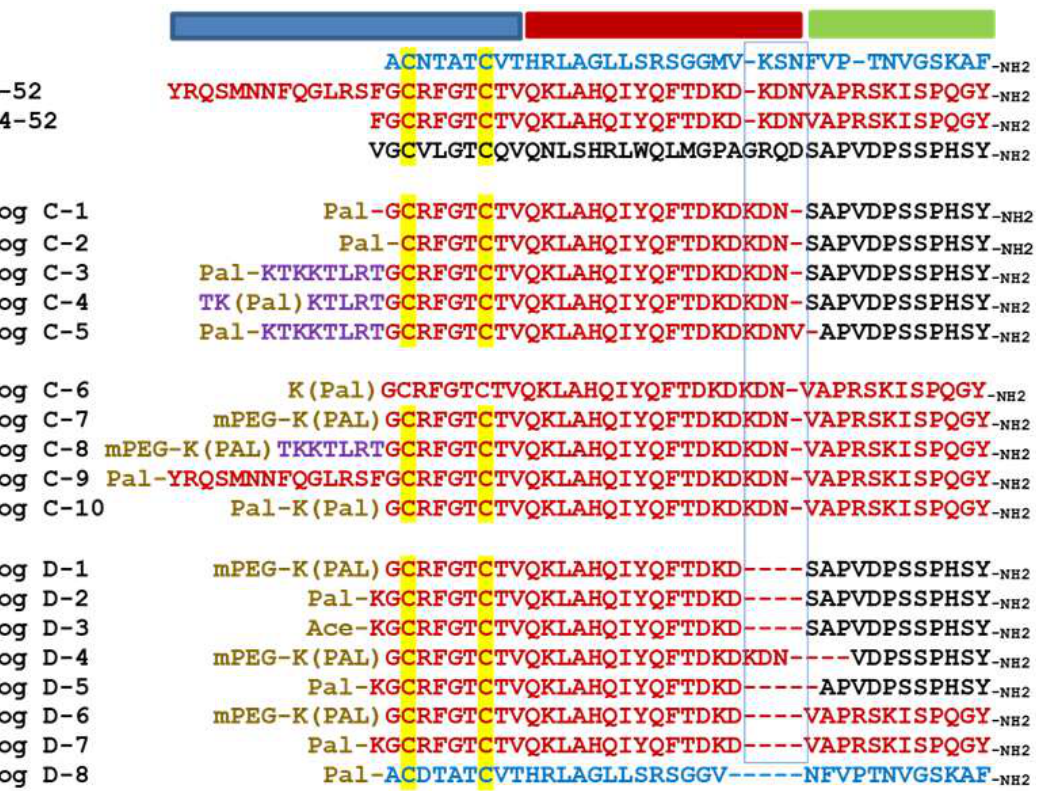
Figure 2. Alignment of analogs with an N-terminal sequence modification or a truncation at the junctional region. The alignment includes CGRP (blue letters), adrenomedullin (red letters), and adrenomedullin 2 (black letters) as well as Analogs C-1 to C-9 and Analogs D-1 to D-8. Cysteine residues that form a disulfide ring are indicated by a yellow background. A putative collagen-binding motif is indicated by purple letters. The origin of individual residues in chimeric analogs is indicated by text colors. The N-terminal modifications, including lysine-conjugated palmitoylation (Pal-K or K(pal)) and mini-PEGylation (abbreviated as mPEG), are indicated by brown letters. Sequence gaps are indicated by dash lines. The putative activation, binding, and junctional regions of these analogs are indicated by blue, green, and red horizontal bars above the alignment, respectively. The motif corresponding to the hinge region of CGRP is indicated by a blue rectangle box.